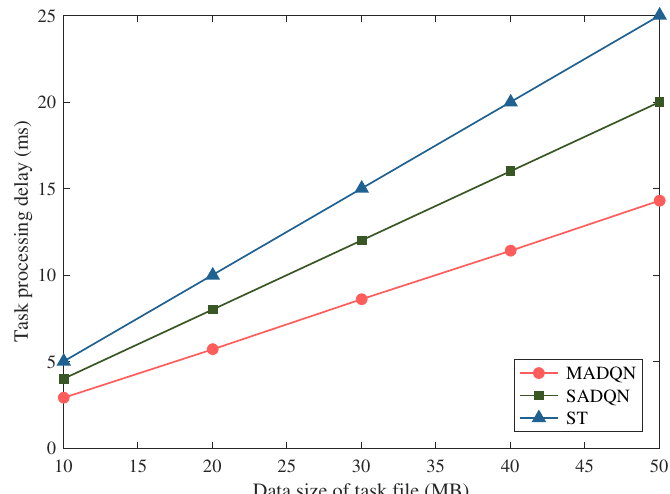
Figure 8. The effect of the data size of the task file on the task processing delay.